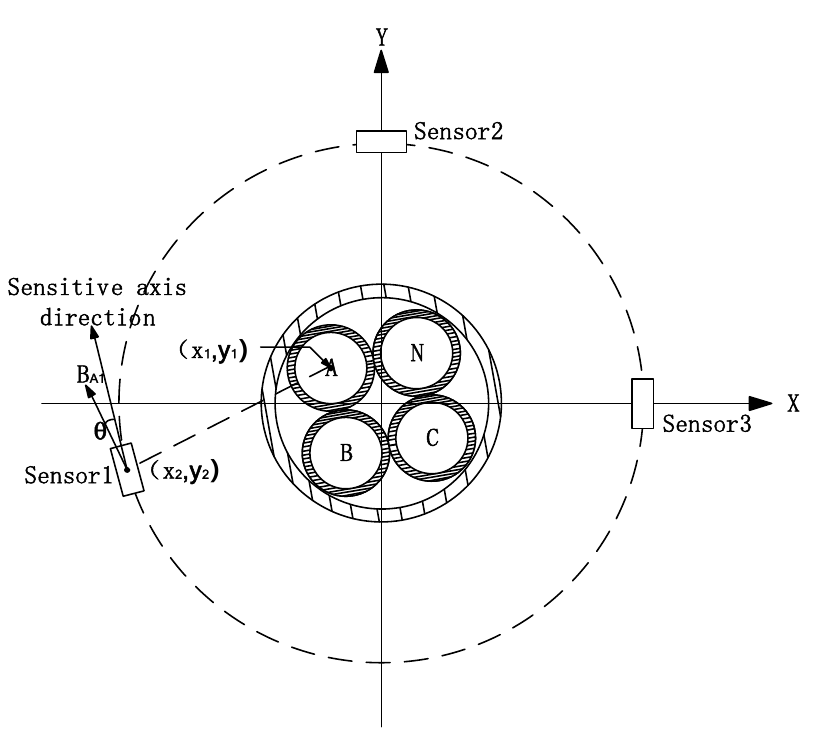
Figure 1. Diagram showing the relationship between the three-phase four-wire power cable and the location of the sensor array.